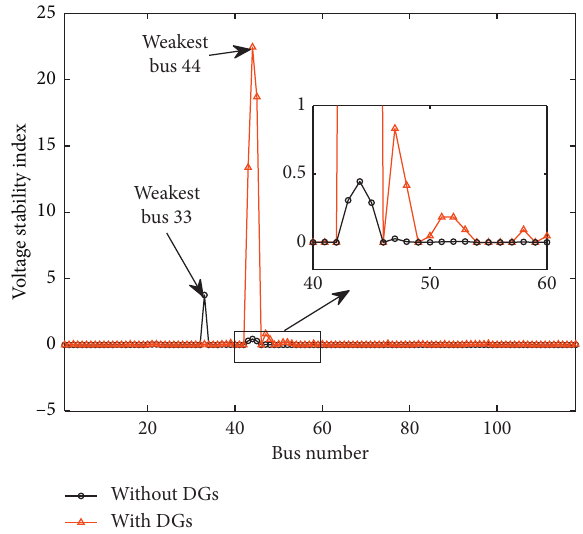
Figure 15: The voltage stability index of 118 buses when using MCPF without and with the integration of